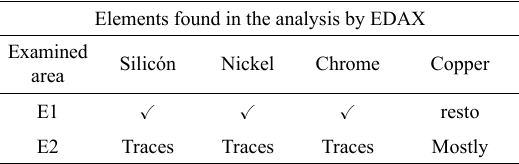
Table 1. resulting elements found in the segregated phase